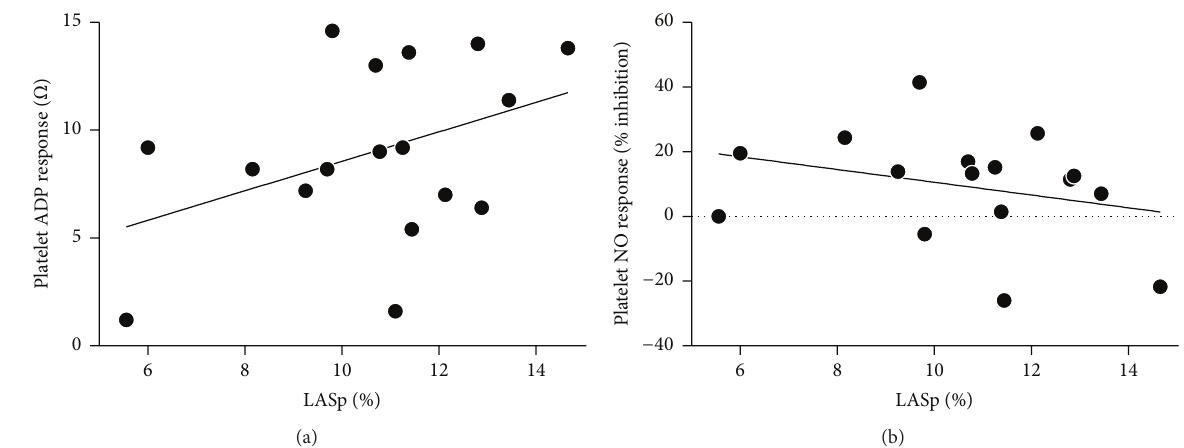
Figure 1: Relationships between peak positive left atrial strain (LASp) and (a) ADP-induced platelet aggregation ( 𝑟 = 0.408 , 𝑝 = 0.104 ) or (b) platelet response to NO ( 𝑟 = −0.290 , 𝑝 = 0.275 ).